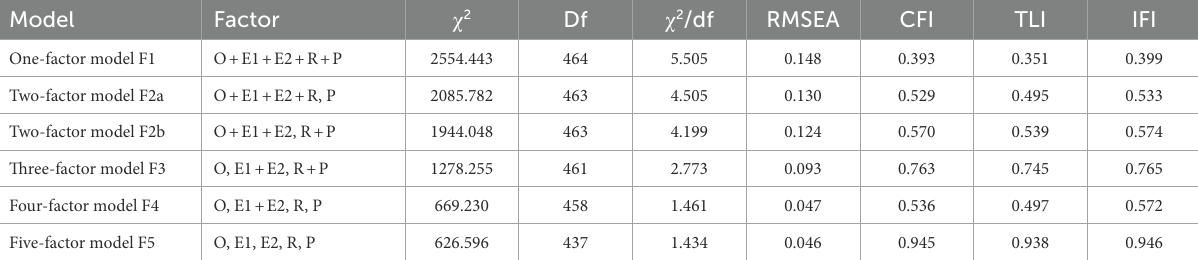
TABLE 2 Results of confirmatory factor analysis.